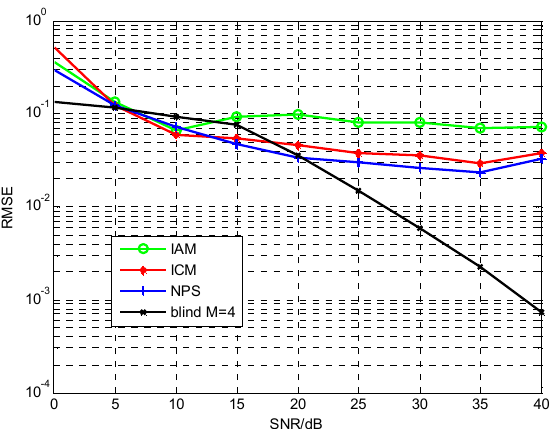
Figure 4. RMSE performance comparisons of preamble-based LS methods and subspace method, with 4QAM, N = 64, M = 4, and N s = 200.